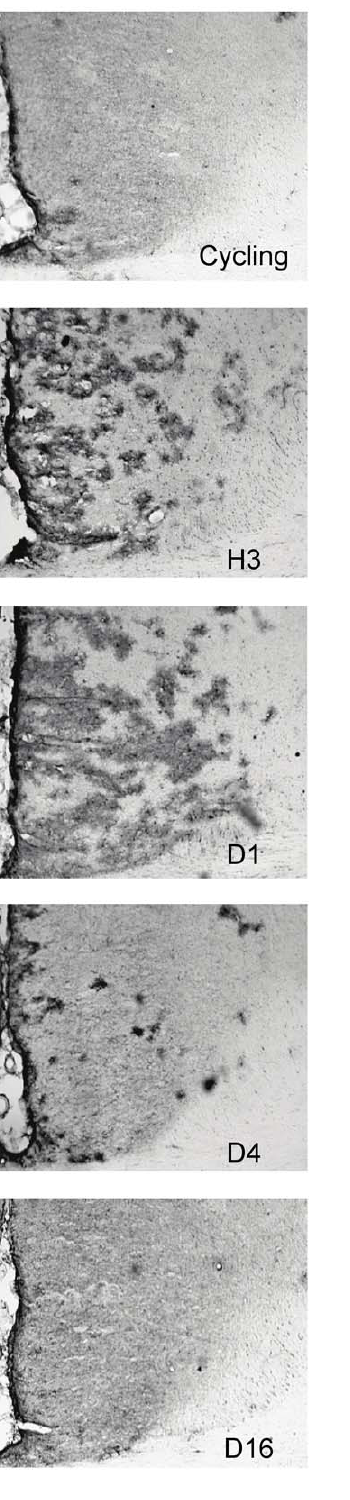
Figure 4. Representative sample of photomicrographs of GS-ir staining within Cg2. Note the upregulation of GS-ir in Day 1